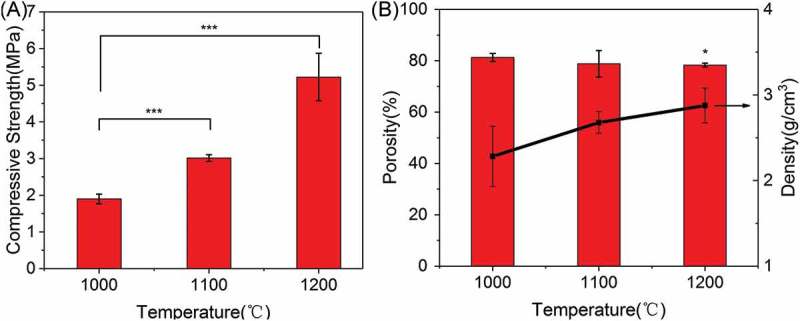
(A) Compressive strength and (B) porosity and density of β-Ca2SiO4 scaffolds sintered at different temperatures. (n = 3; * and *** indicate significant differences, p < 0.05 and p < 0.005).